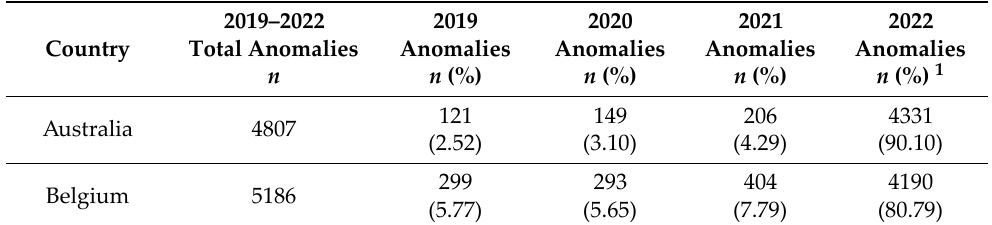
Table 3. Anomalies observed in the time series comparing the difference in Google Trends API data collected before and after the implemented changes to the data